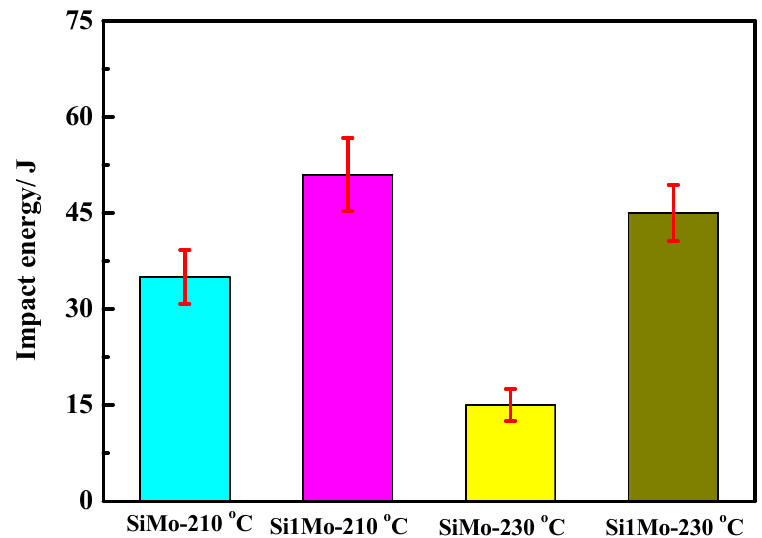
Figure 9. Impact energy of the steels austempered at different temperatures for 8 h.